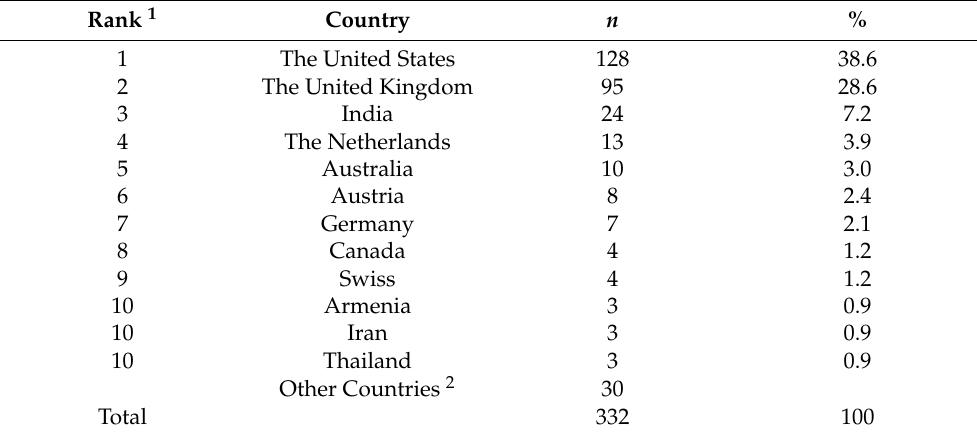
Table 1. Countries with brain organoid research-related published news reports.